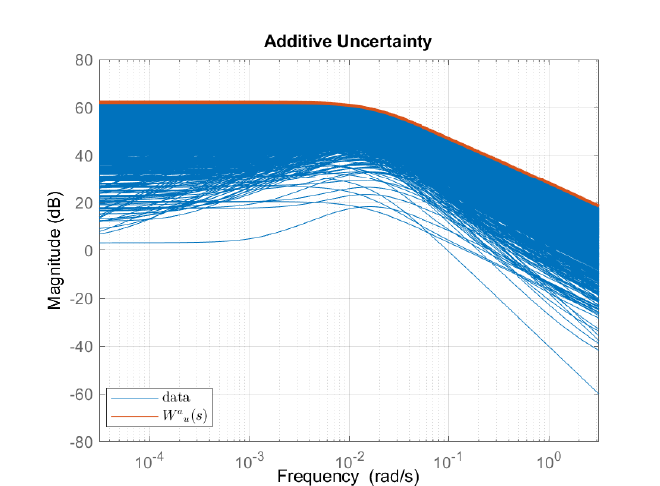
Figure 9. Modulus of the error between G n ( s ) and the analysed plants (in blue), fitting obtaining with a second order W a u ( s ) (in